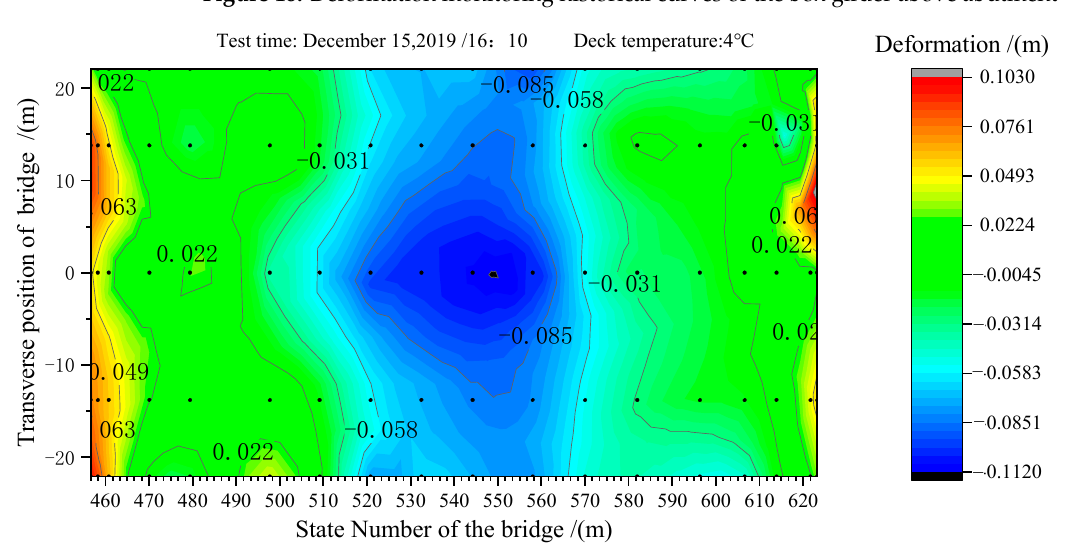
Figure 18. Deformation monitoring historical curves of the box girder above abutment #4.